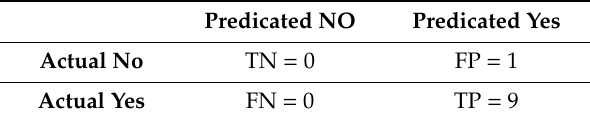
Table 7. Confusion matrix of mildew (zombie) class.